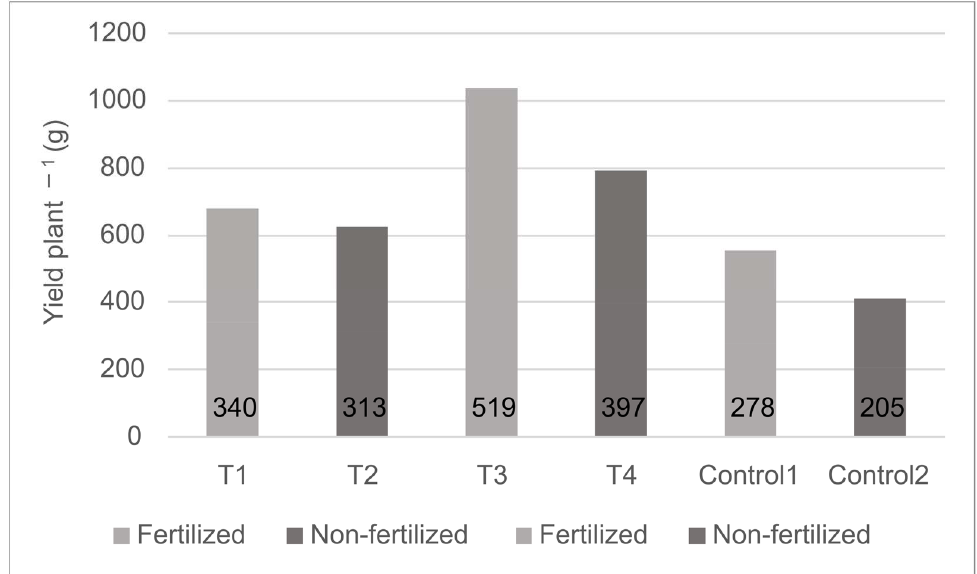
Figure 9. Effect of microbial treatment on the performance of sweet potato storage root yield per plant at Ásotthalom in 2020. T1: soaking sweet potato cuttings in the mixed microbial suspension before planting in the fertilized unit; T2: same preparation of cuttings as in T1 with planting in the non-fertilized unit; T3: same as T1 with an additional inoculation of the soil; T4: same as T2 with an additional inoculation of the soil; Control 1: no microbial treatments applied, planting in the fertilized unit; Control 2: no microbial treatments applied, planting in the non-fertilized unit.